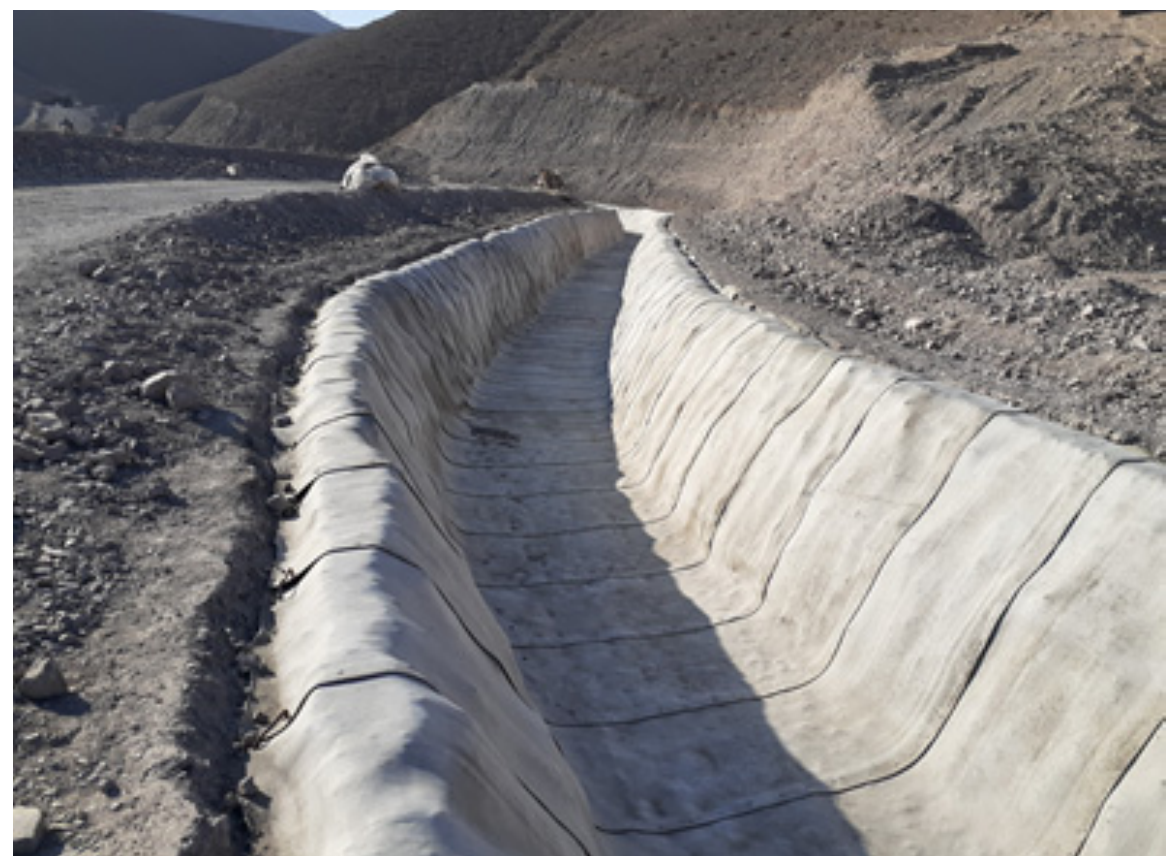
Figure 18. Collection and diversion system for non-contact water–perimeter ditches [27].